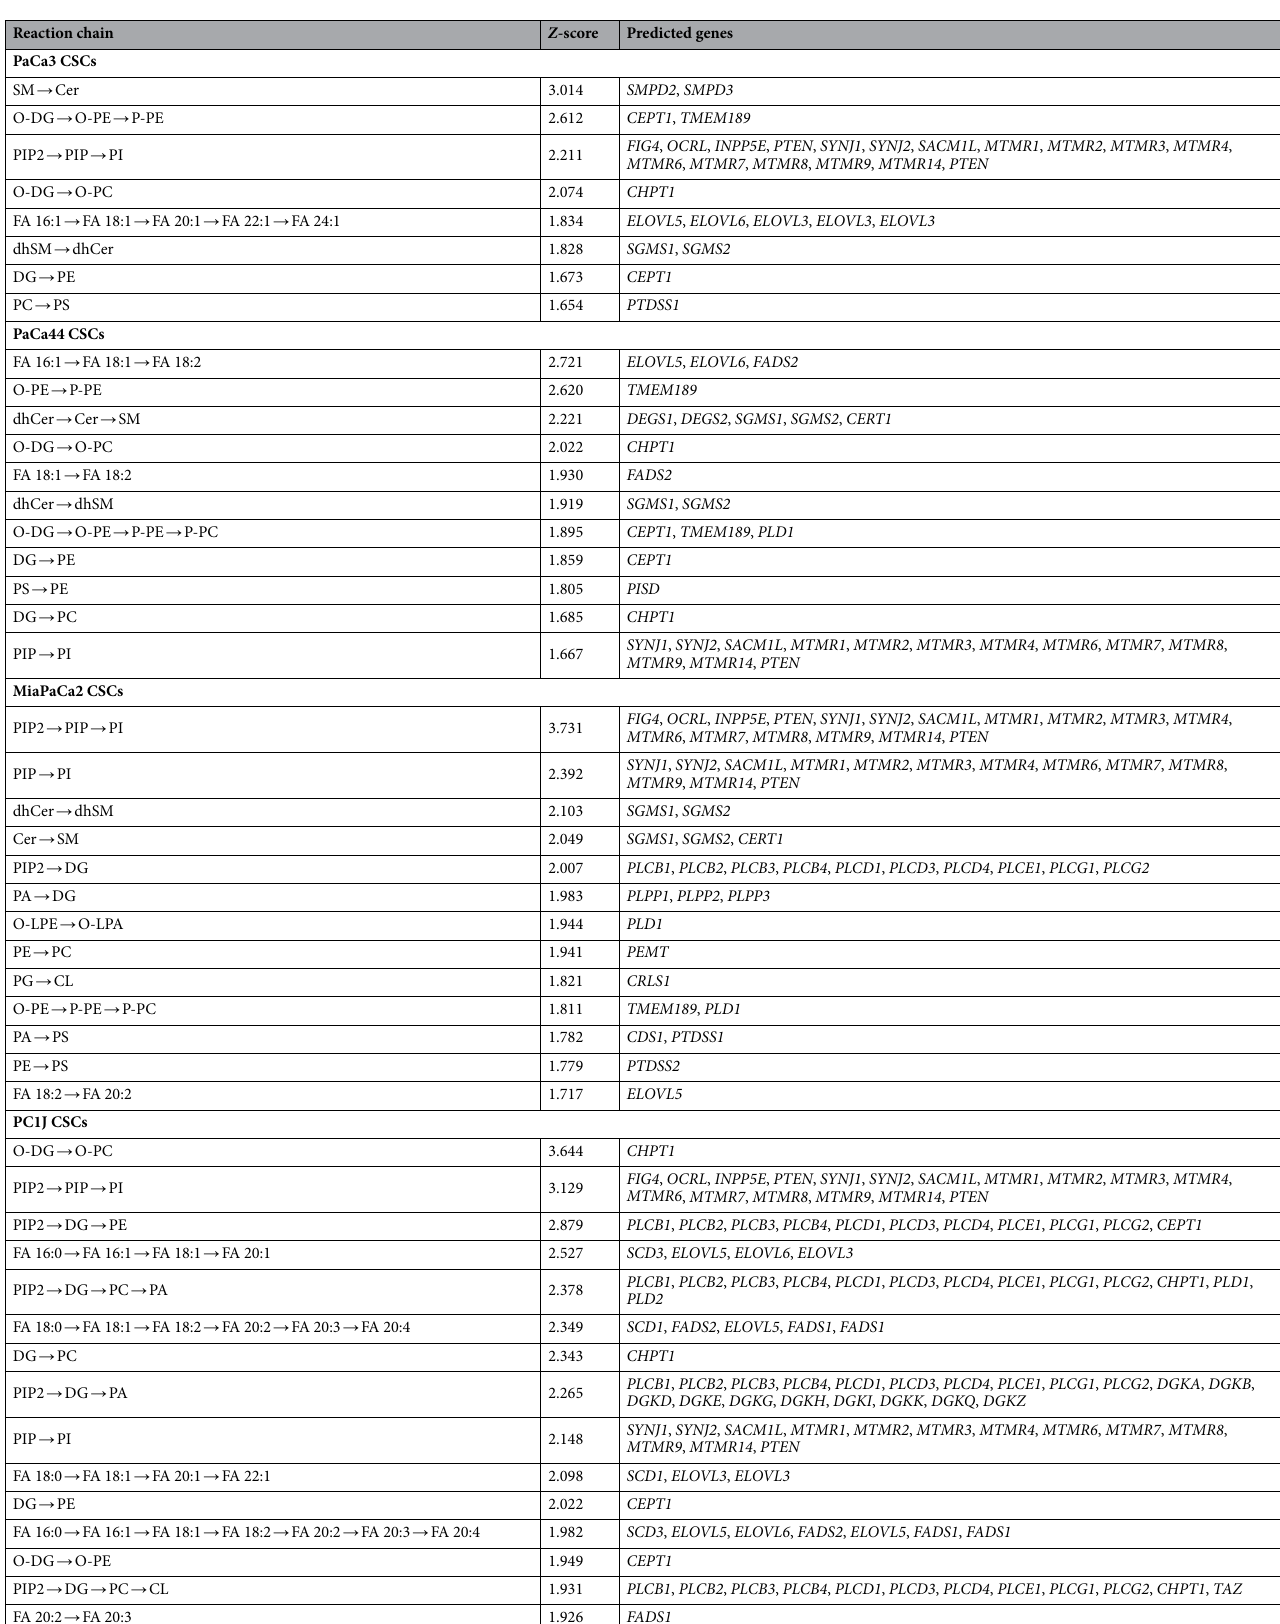
Table 1. BioPAN predicted significantly active reactions chains (Z > 1.645) of lipid class and FA species and relative genes for each reaction of PCSC lines.